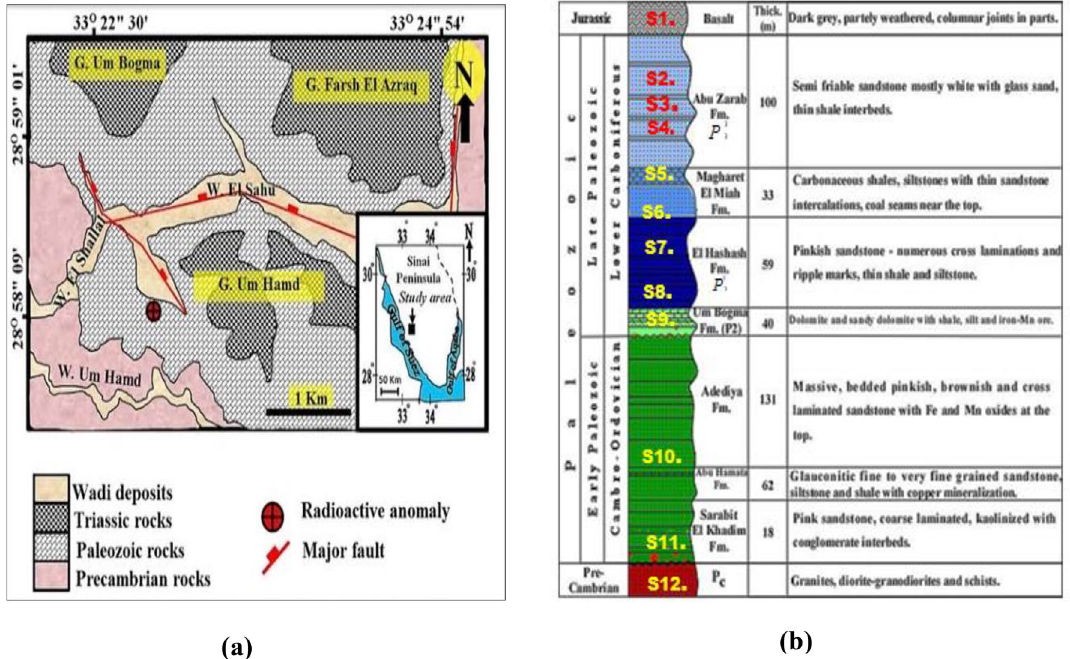
Fig. 1 a Geologic map of the studied area and b Southwest Sinai: Lithostratigraphic segment of Precambrian and Paleozoic rocks (following El